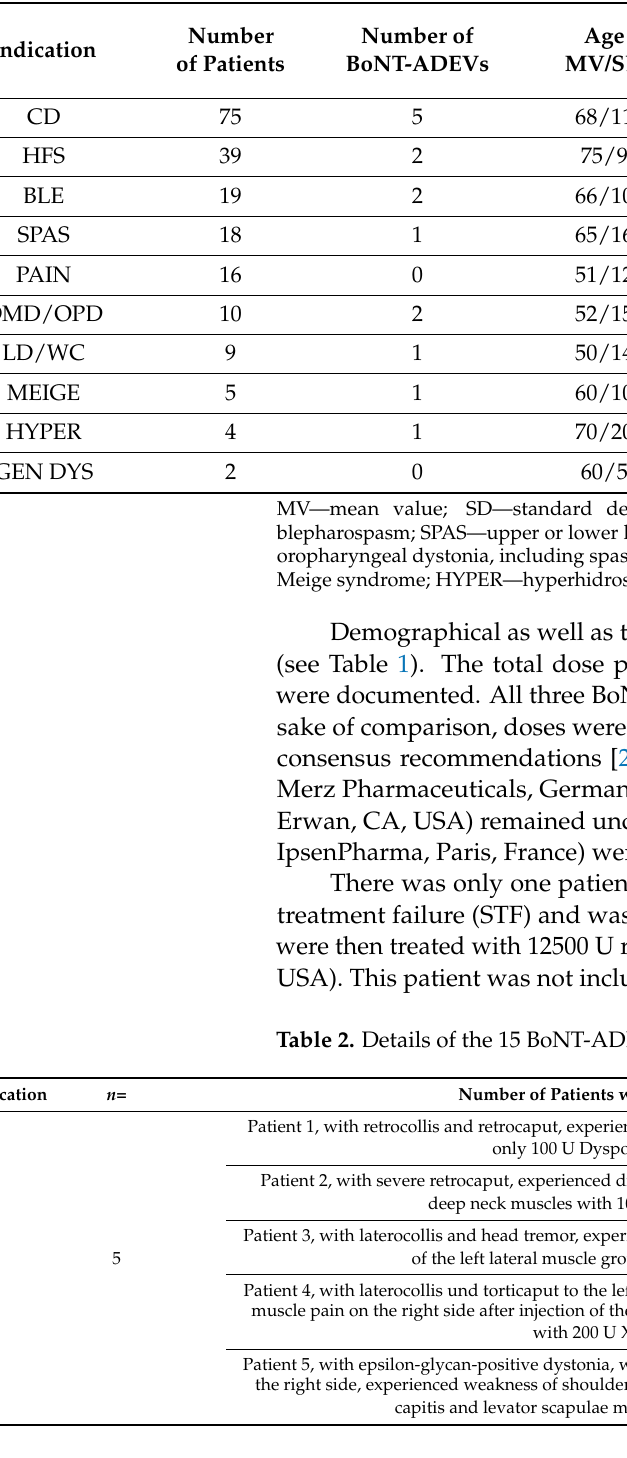
Table 1. Demographical data, treatment-related data, and percentage of BoNT-ADEVs.